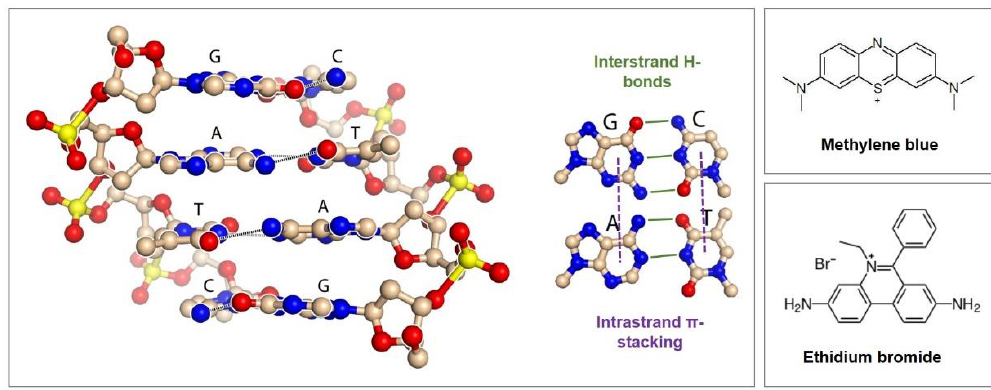
Figure 9. In the DNA helix, the aromatic rings of the bases form π stacks that are responsible for the noncovalent attractive force between the rings. Aromatic redox mediators can intercalate into the helix by inserting their planar, aromatic groups in an almost perpendicular position into the double helix axis. Adapted from the work of the authors of [85].